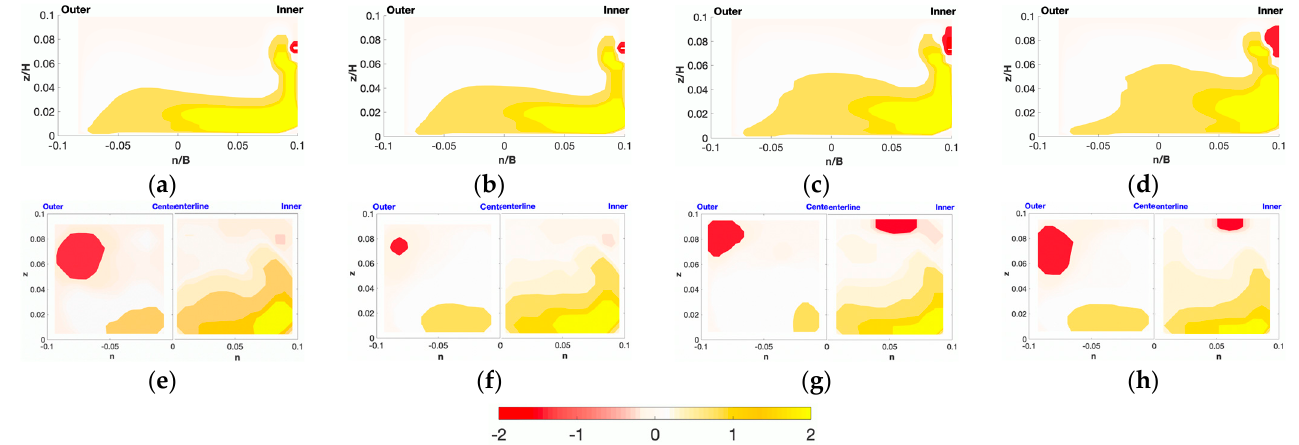
Figure 7. Vortex contour of the secondary flows under different conditions: ( a , e )—No jet; ( b , f )—S= 3.5; ( c , g )—S = 10; ( d , h )—S = 16.5. Figures in the first row represent the numerical results, and the ones at the second row are from the experimental results.